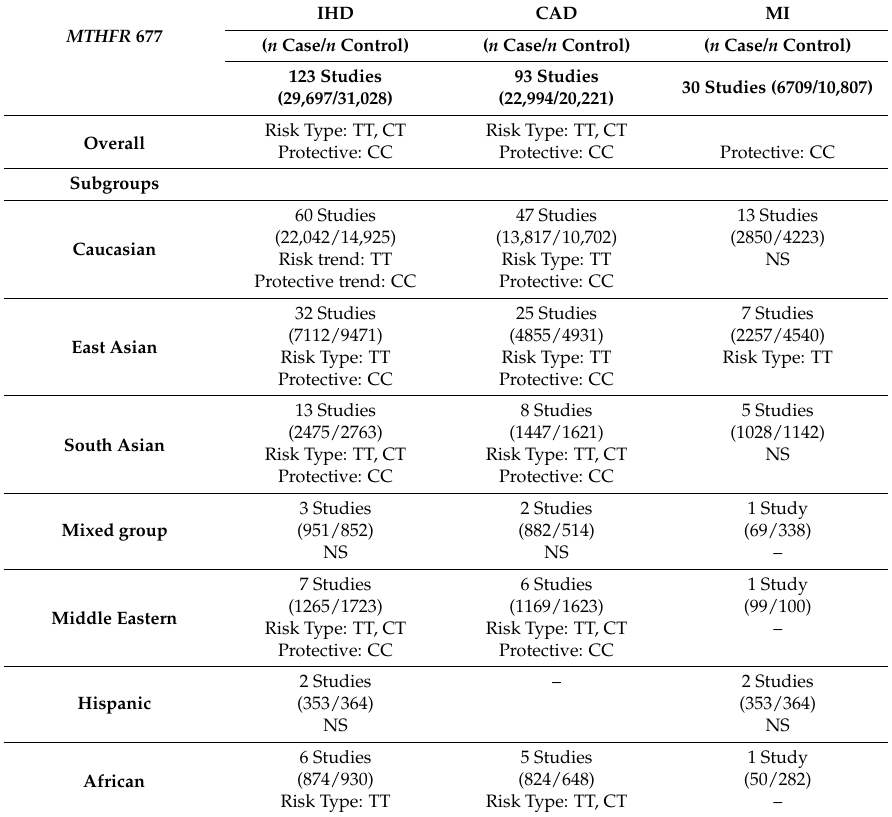
Table 1. Schema of significant findings across studies on MTHFR 677 genotypes and risk of ischemic heart disease